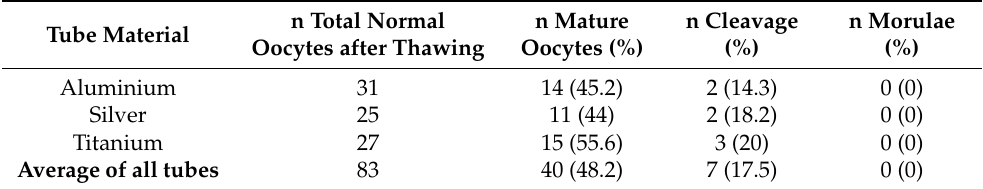
Table 3. Developmental competence of the thawed oocytes presenting a normal morphology, after IVM and ICSI. n Total Normal n Tube Material Oocytes after Thawing